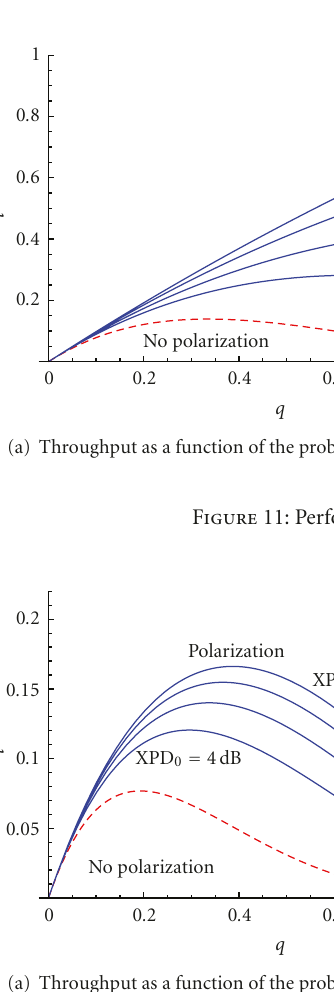
Figure 12: Performance analysis of a dual-polarized half-duplex system. The distance of the transmission is d 0 = 15m and the 5 interferers are located at d = 25 m of the receiver.